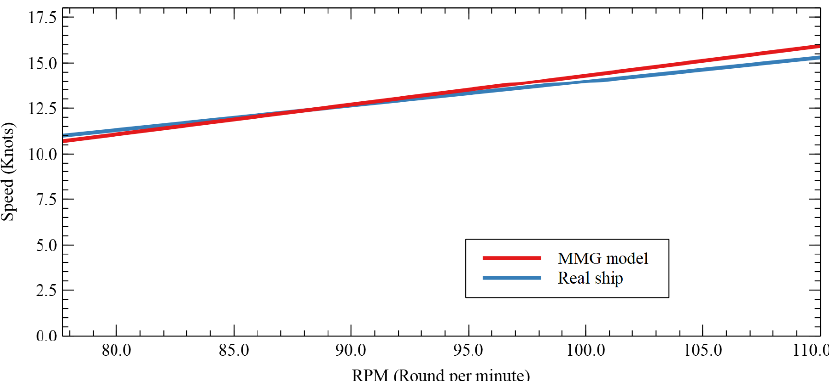
Figure A1. Digital MMG model and real ship model turning cycle.